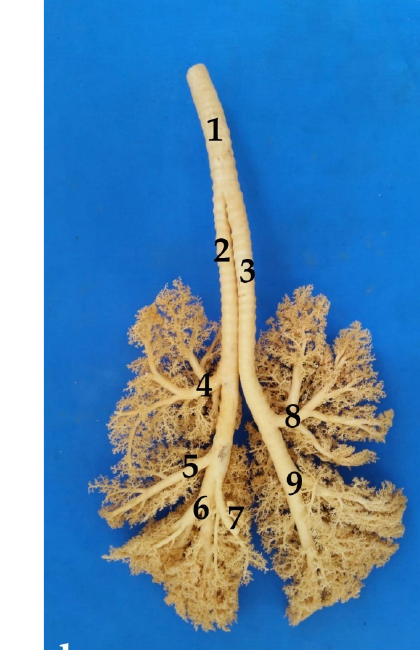
Figure 7. Trachea section, ventral view: (1) cartilaginous rings; (2) membranous part. The diameter of the tracheal lumen is 1.5 cm in juveniles and 2.5 cm in adults, whereas the tracheal circumference is about 6 cm in the former and 6.8 cm in the latter (Table 1).